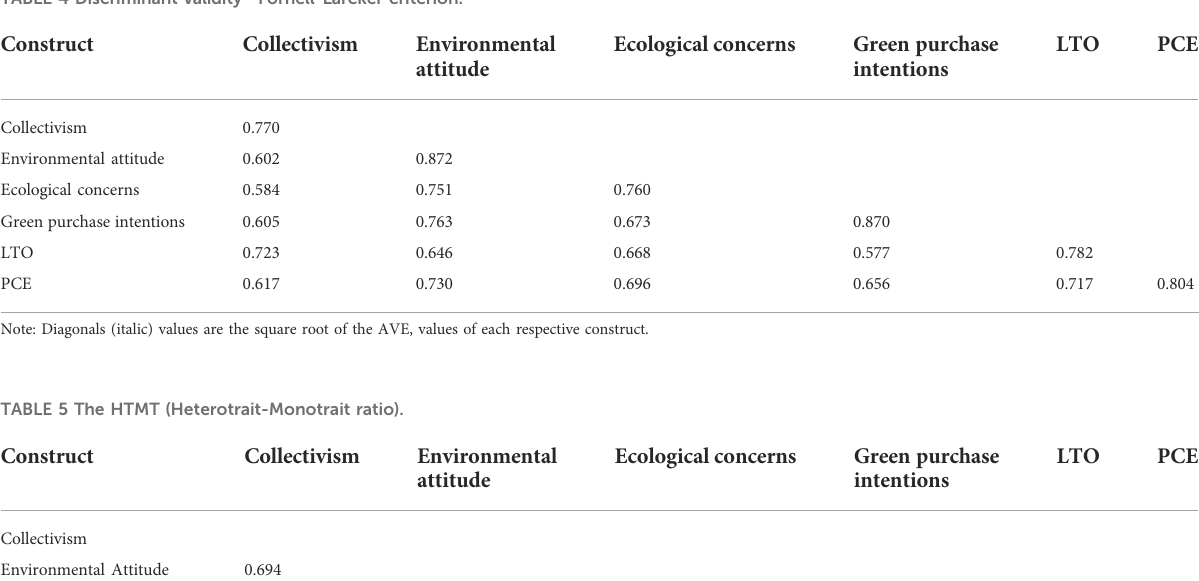
TABLE 4 Discriminant validity — Fornell-Larcker criterion.